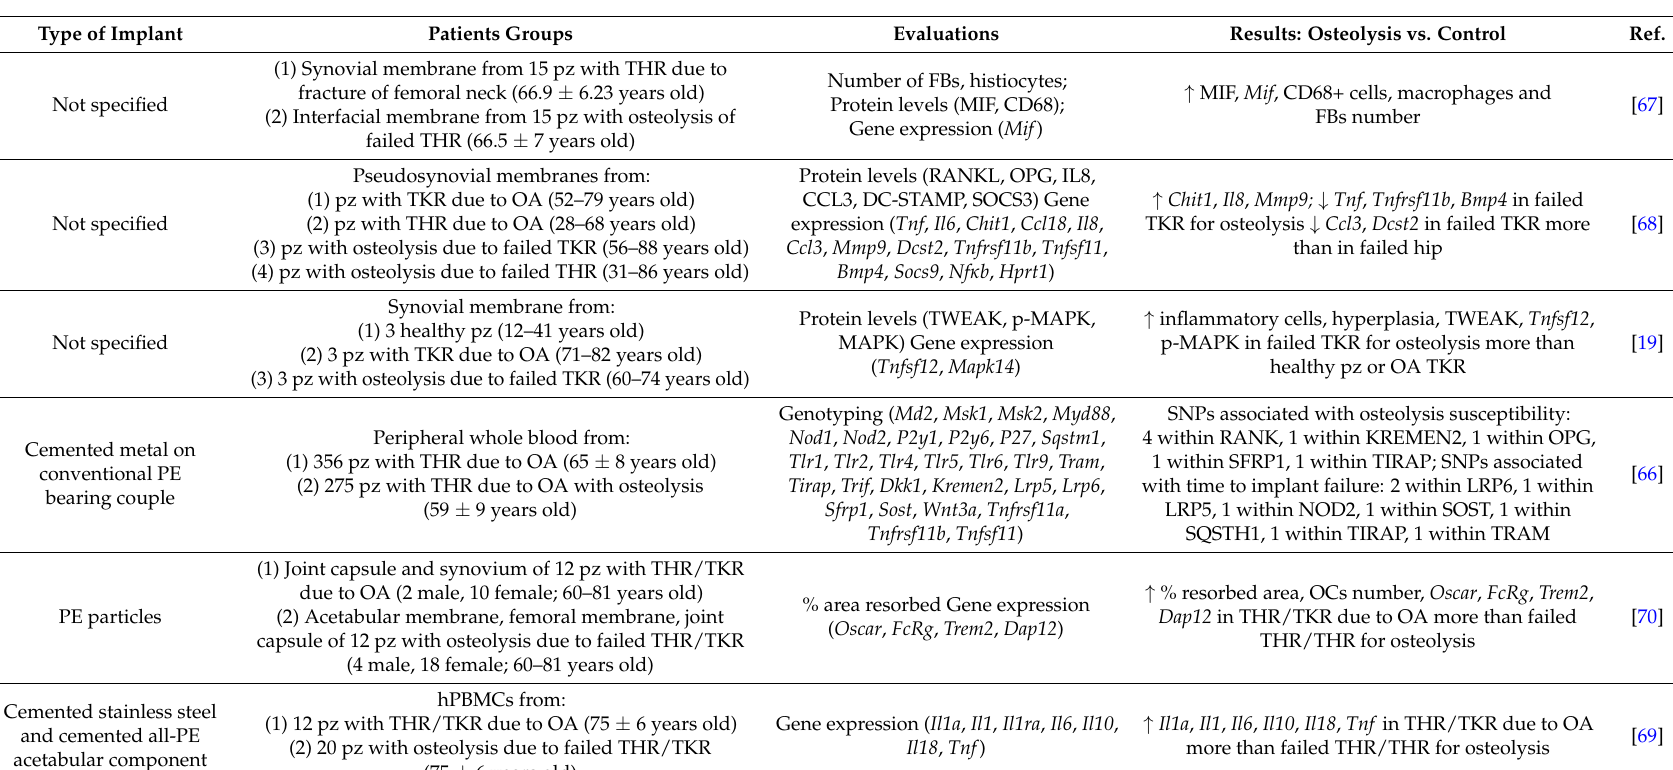
Table 3. Clinical